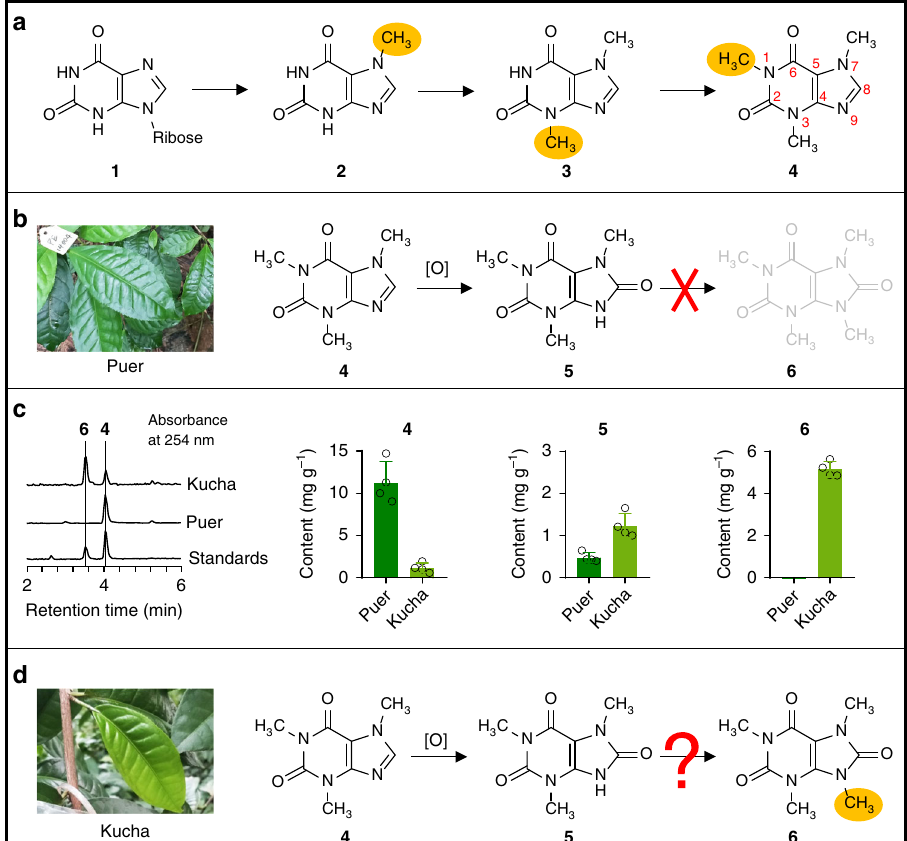
Fig. 1 Qualitative and quantitative analysis of major xanthine alkaloids in Puer and Kucha. a The main biosynthetic pathway of caffeine ( 4 ) from xanthosine ( 1 ). b Conversion of caffeine to 1,3,7-trimethyluric acid does not progress to theacrine in Puer leaves. c The content of caffeine ( 4 ), 1,3,7- trimethyluric acid ( 5 ) and theacrine ( 6 ) in Puer and Kucha leaves. The left panel shows the HPLC analysis of 4 and 6 at absorbance wavelength of 254 nm. The right three panels show the quanti fi cation of 4 , 5 , and 6 by HPLC-MS. Data represents mean ± SD ( n = 4). The corresponding dot plots are overlaid on the fi gure. d Conversion of caffeine to 1,3,7-trimethyluric acid then to theacrine in Kucha